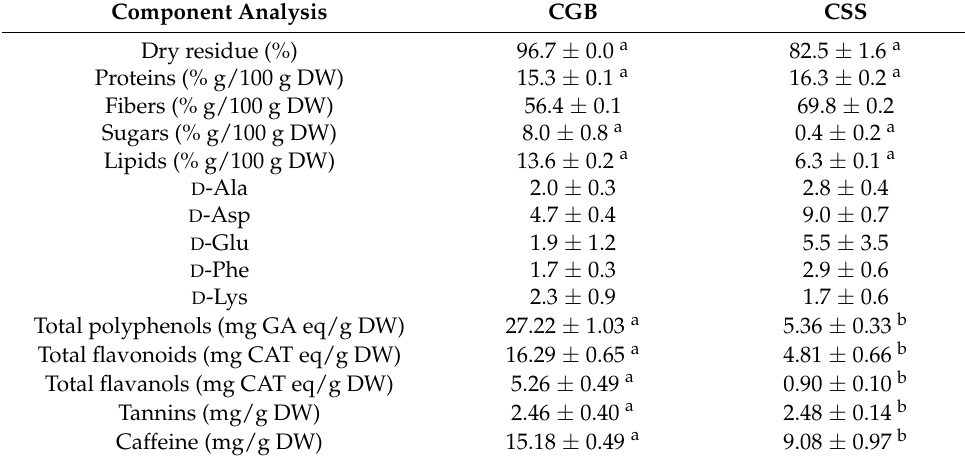
Table 1. Raw composition of coffee by-products: proteins, fibers, sugars, and lipids are expressed as dry matter (g DW). The degree of racemization of the proteins of coffee by-products is expressed as % of D -amino acid on the sum ( D + L )-amino acid. Results of proximal analysis, phenolic compounds, and caffeine contents of coffee by-products are reported as the mean ± sd and expressed on dry matter (g